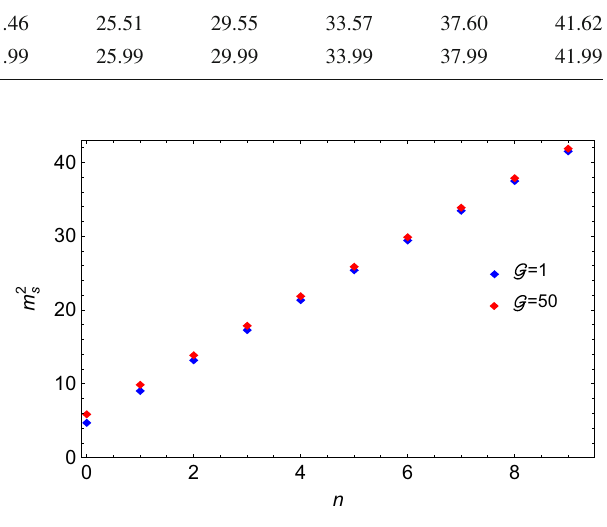
Fig. 2 The mass spectrum of scalar mesons at zero temperature for two different values of